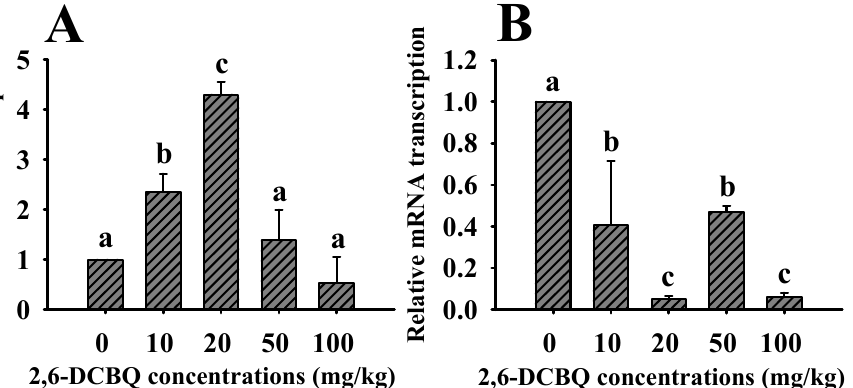
Figure 2. The effects of different concentrations of 2,6 ‐ DCBQ on the expressions of Nrf2 ( A ) and keap1 ( B ) of mice, after 30 d of exposure. Values are plotted as the mean ± SD, and different letters denote significant difference at p < 0.05.